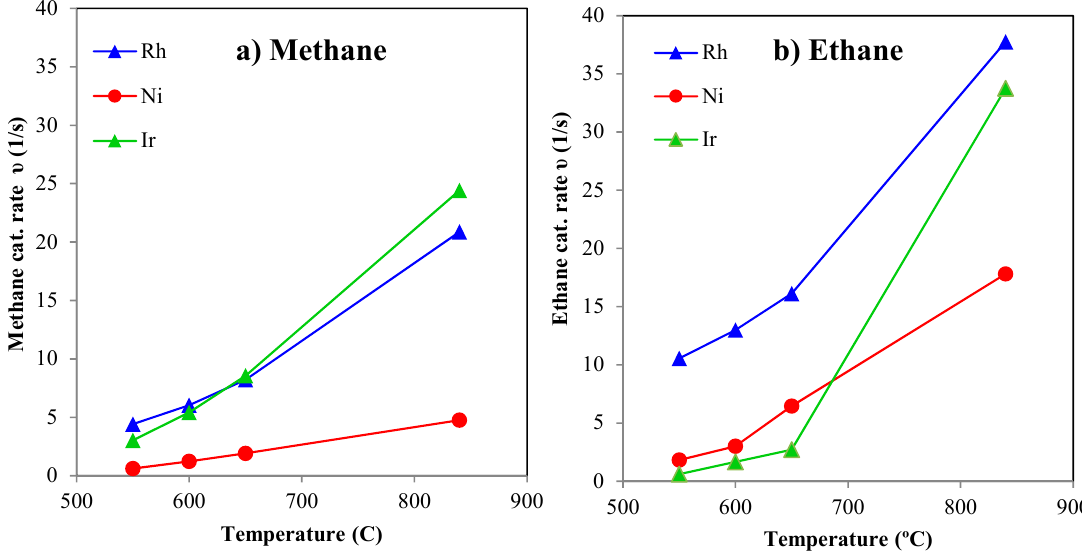
Figure 4. Comparison of turnover steam reforming rates for the Rh, Ir, and Ni catalysts using ( a ) methane, and ( b ) ethane feeds (S / C = 3, τ = 30 ms; methane feed = 15.9 vol%, ethane feed = 14.8 vol%).